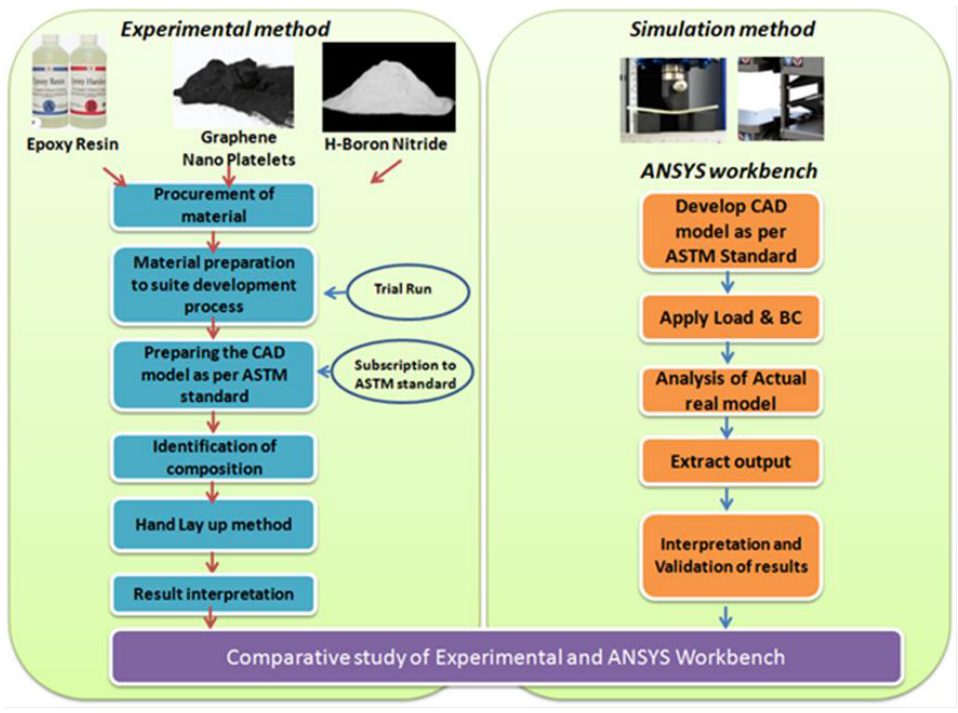
Figure 10. Process map for simulation vs. experimental work.